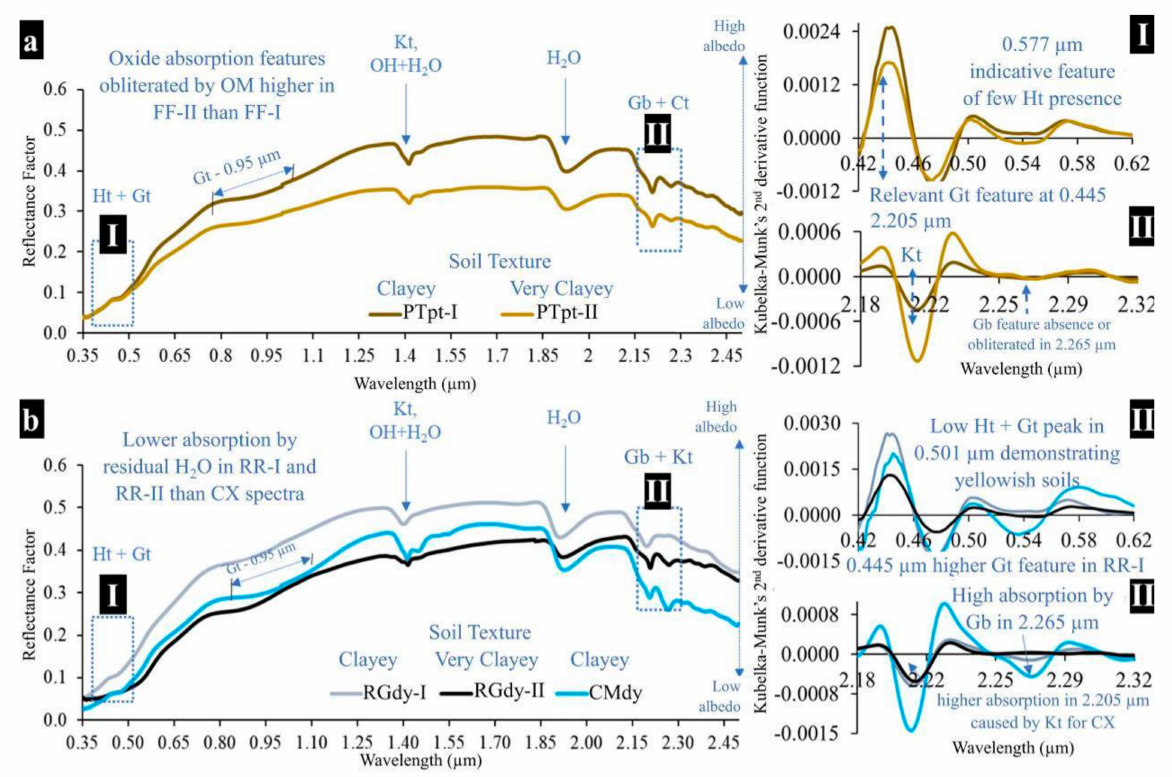
Figure 6. Interpretation of the spectral behavior of ( a ) Petric Plinthosol (PTpt-I and PTpt-II) and ( b ) Dystric Regosol and Dystric Cambisol (RGdy-I, RGdy-II, and CMdy). Ht: Hematite; Gt: Goethita; Kt: Kaolinite; Gb: Gibbsite; and OM: Organic